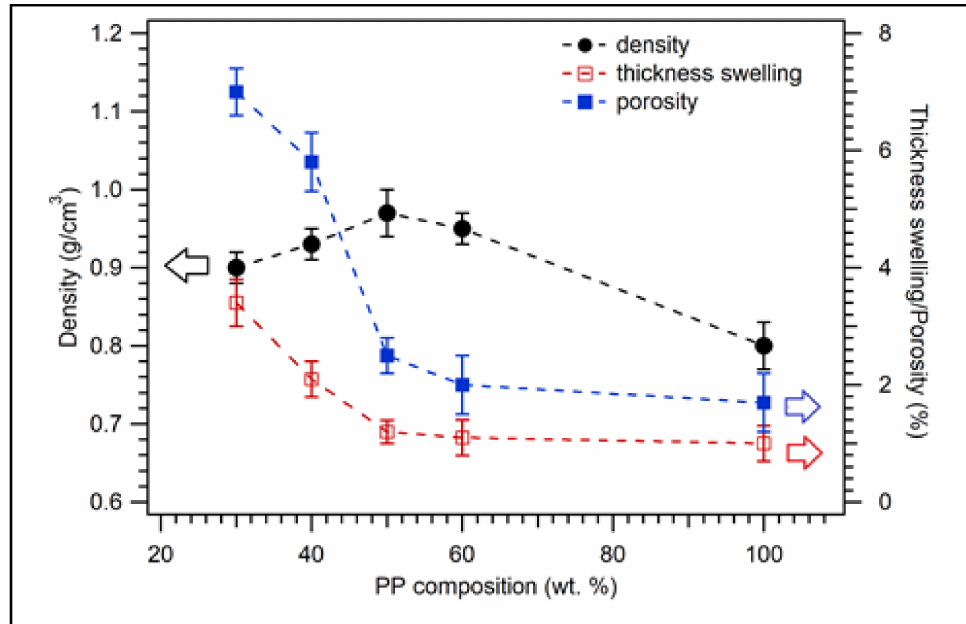
Figure 2. Physical properties of coconut shell biocomposite for various PP compositions with 200 mesh of coconut shell